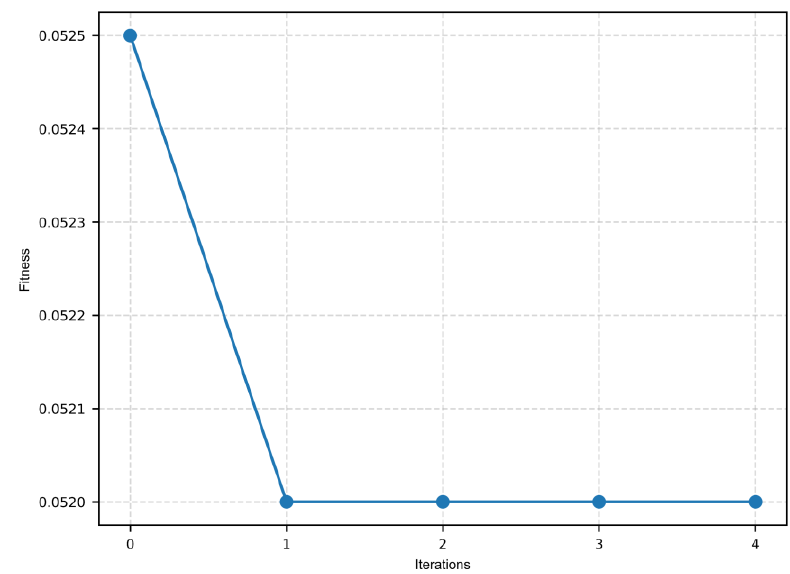
Figure 5. Wolf α ’s fitness performance variation along the process of GWO Figure 5. Wolf α’ s fitness performance variation along the process of GWO iterations.